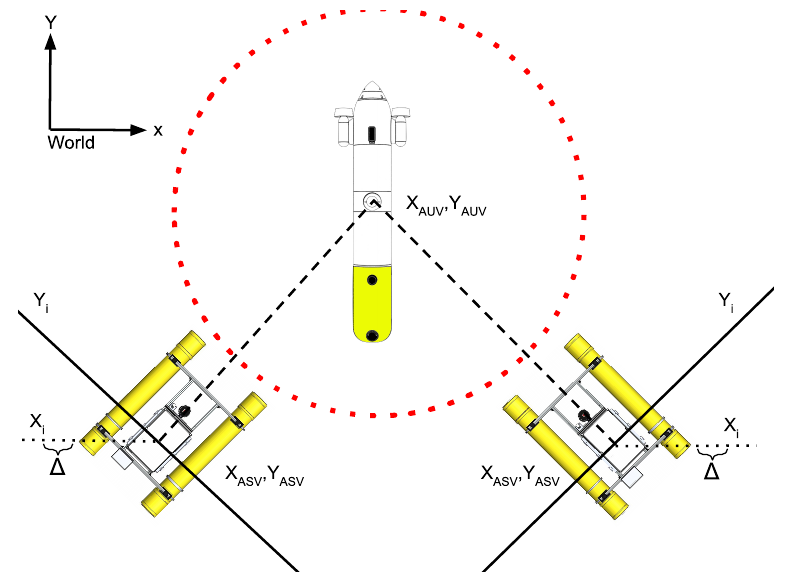
Figure 6. Red dotted line represents the repulsion radius, and black line represents the perpendicular line between the ASV and the AUV, Y i . Finally the black dotted line represents the X i values where the ∆ is the step increment. Note that the reference coordinates has been placed at the top left-hand side of the image